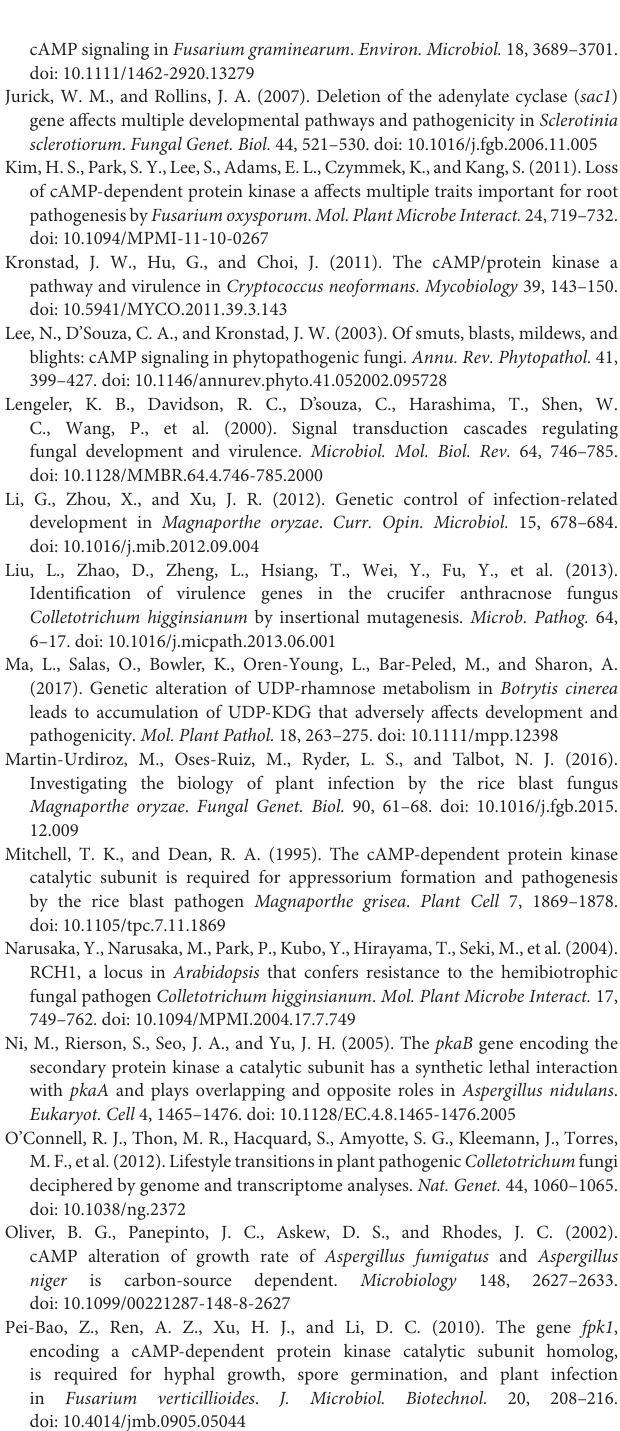
Supplementary Table S2 | Comparison of growth rate, conidial production, and pathogenicity among mutants, complementary strains and the wild type strain CH-1 of C. higginsianum . Means and standard deviations were calculated from three replicates. Different letters in the graph indicate statistical differences, P ≤